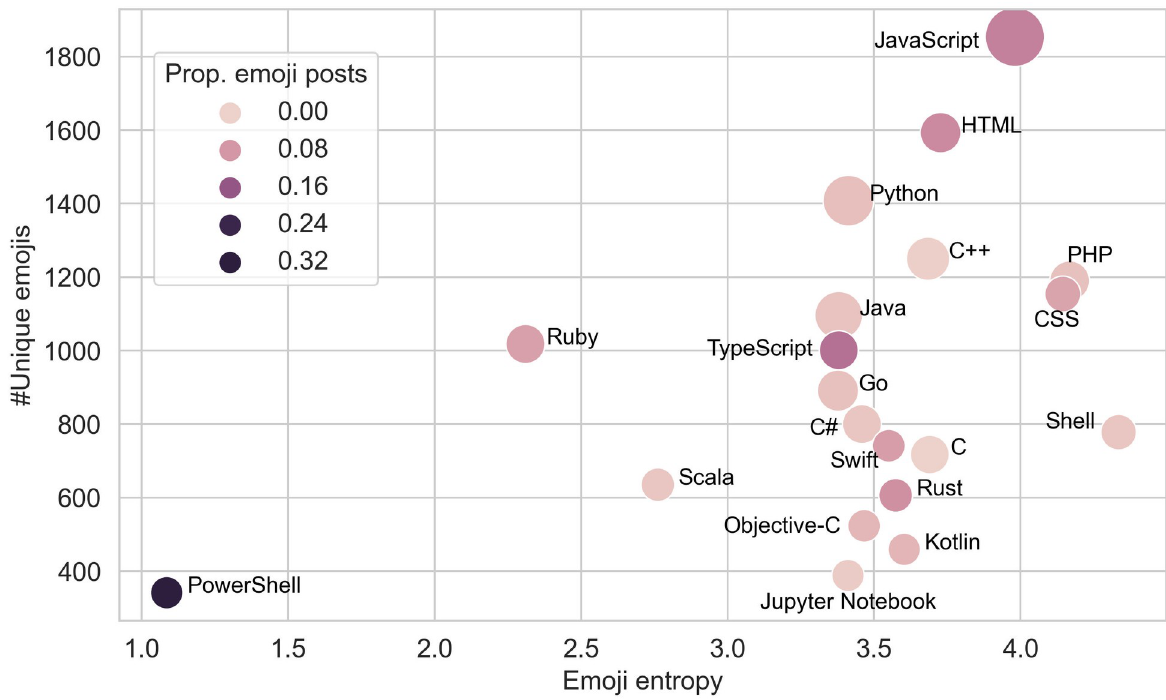
Fig 1. Emoji usage varies in repositories that have different primary programming languages. Dot: a language; size: number of repositories; color: proportion of emoji posts. JavaScript developers use a larger variety of emojis and a larger proportion of their posts contain emojis.